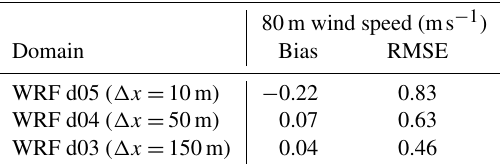
Table A2. Eighty-meter wind speed bias and RMSE between WRF–LES–GAD on domains d03, d04, and d05 and SW_TSE04 tower measurements for the stable case study from